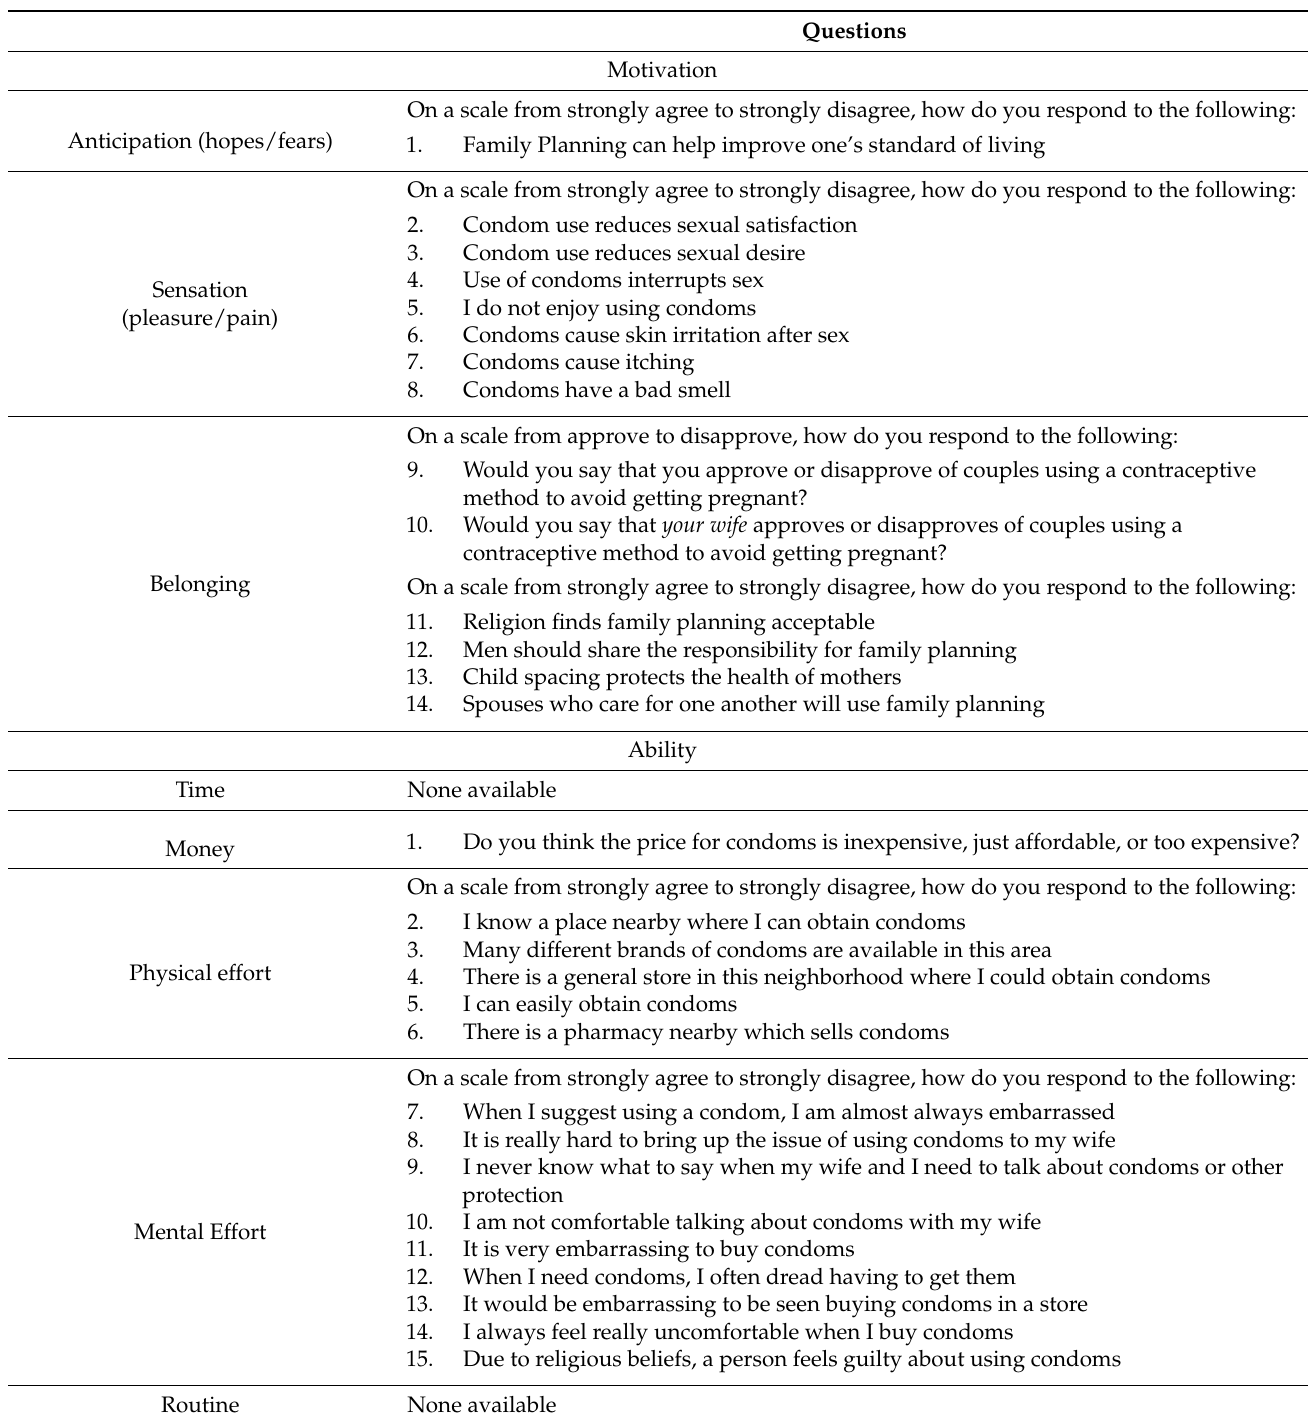
Table 1. Pakistan survey questions related to the Fogg Behavior